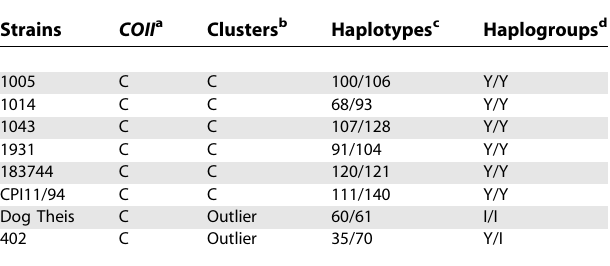
Table 2. Nuclear and Mitochondrial Markers of T. cruzi Inferred in This